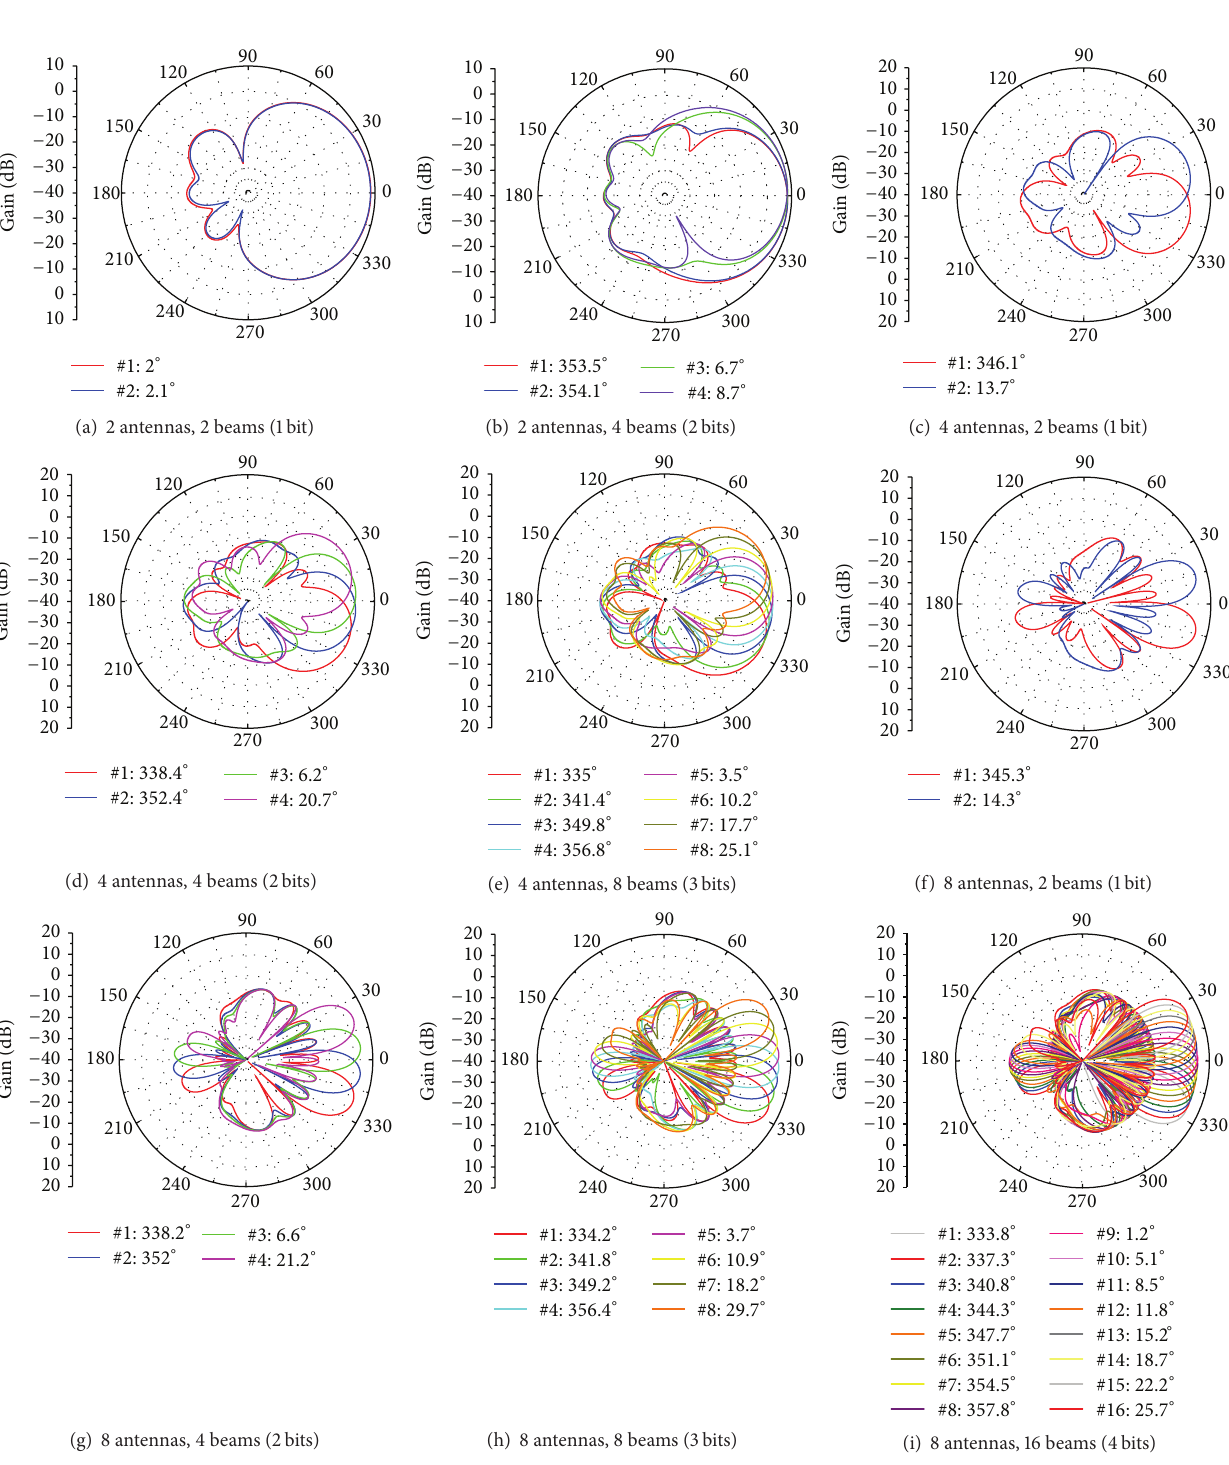
Figure 10: Gain patterns for the analyzed scenarios: linear arrays of 2, 4, and 8 elements. All patterns were synthesized with SLL = −20 dB below the main